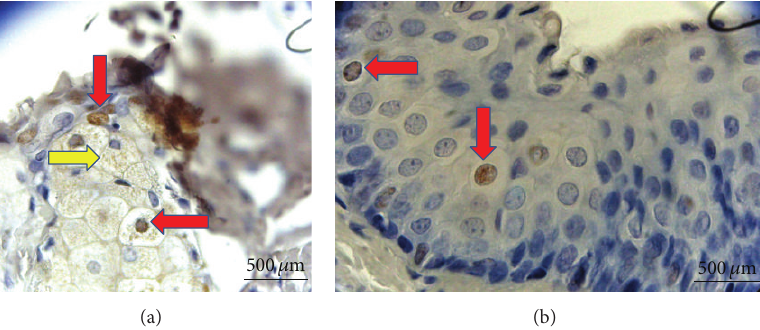
Figure 6: BrdU labeled MSCs were shown to infiltrate the meibomian glands and conjunctival epithelium. (a) Meibomian gland infiltration of BrdU labeled MSCs. Cells with BrdU + stained nucleus (red arrows). Spread of BrdU stained areas to the cytoplasm of some cells (yellow arrow). (b) BrdU + cells in the conjunctival epithelium (red arrow) (Leica HMLB45: Germany, 2000; magnification: ×